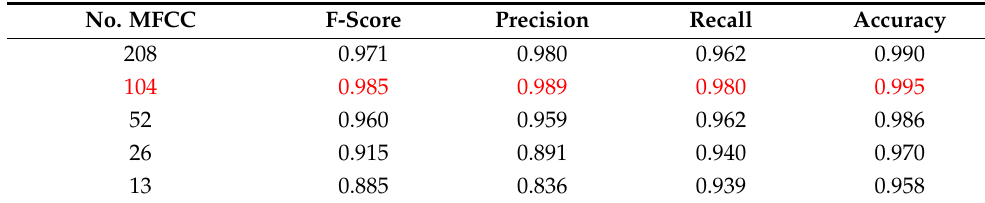
Table 11. Performance of the LSTM fault classifier with different numbers of cepstral coefficients extracted for every audio channel. No. MFCC F-Score Precision Recall Accuracy 208